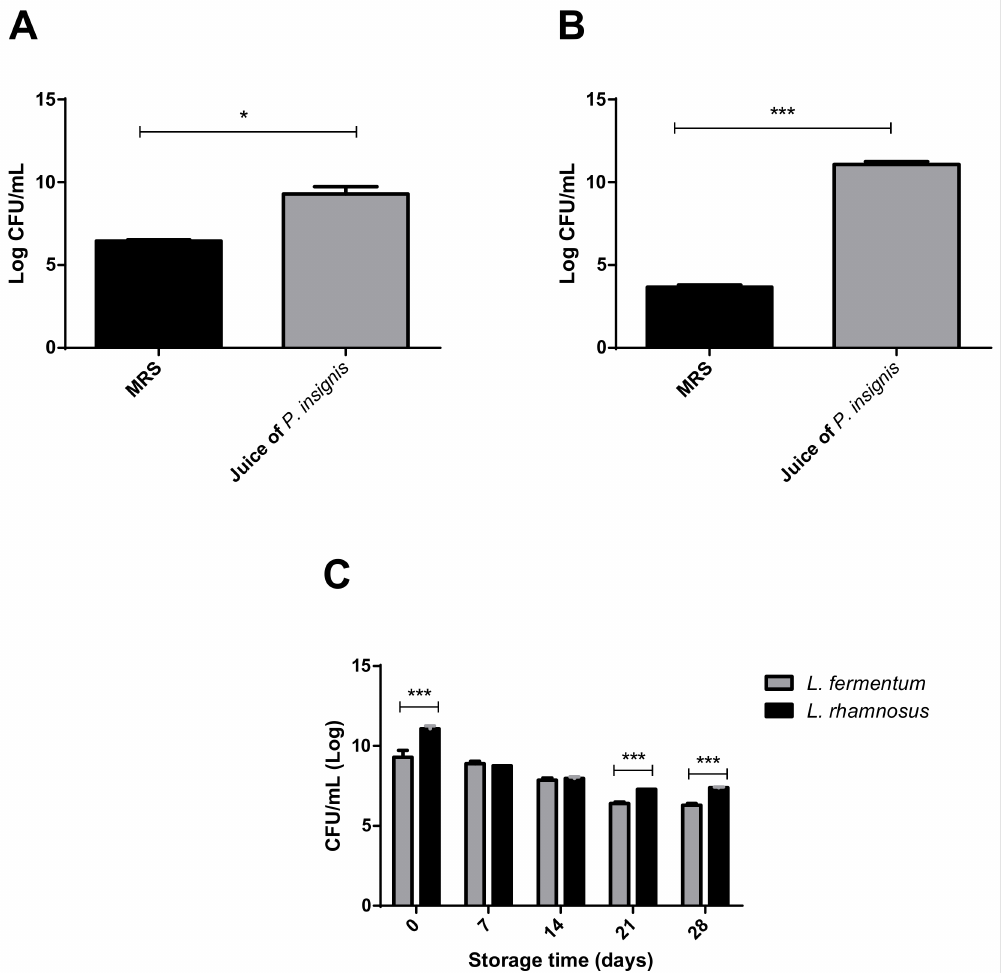
Figure 1. Evaluation of the growth of strains of Lactobacillus in the juice of Platonia insignis (bacuri). ( A ) Comparison of Limosilactobacillus fermentum ATCC 23,271 growth in MRS Agar and in P. insignis juice after 48 h of incubation. ( B ) Com- parison of Lacticaseibacillus rhamnosus ATCC 9595 growth in MRS medium and in P. insignis juice after 48 h of incubation. ( C ) Comparison of the effect of storage on P. insignis juice on the population of L. fermentum ATCC 23,271 and L. rhamnosus ATCC 9595 in Platonia insignis juice. * Statistical differences with p < 0.05; *** Statistical differences with p <